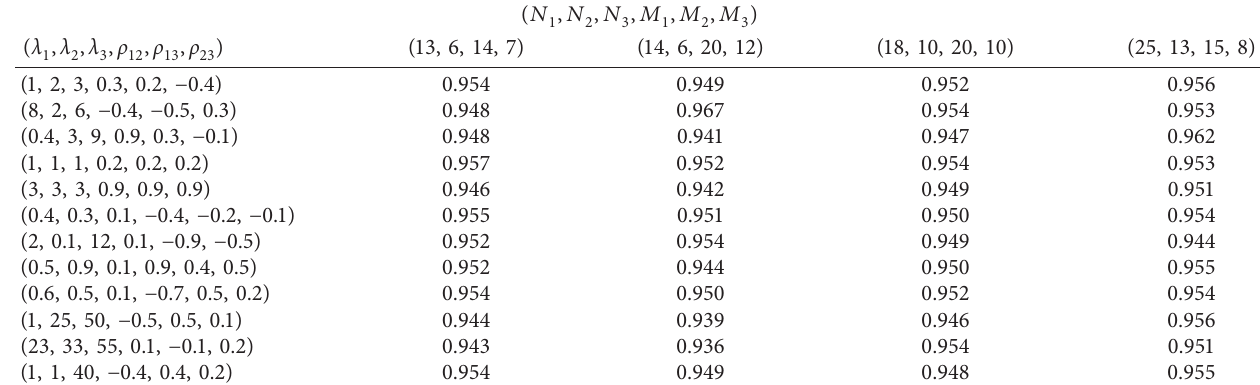
Table 1: Monte Carlo estimates of the coverage probabilities of the confidence region; Σ � diag ( λ 1 ρ ρ 12 13